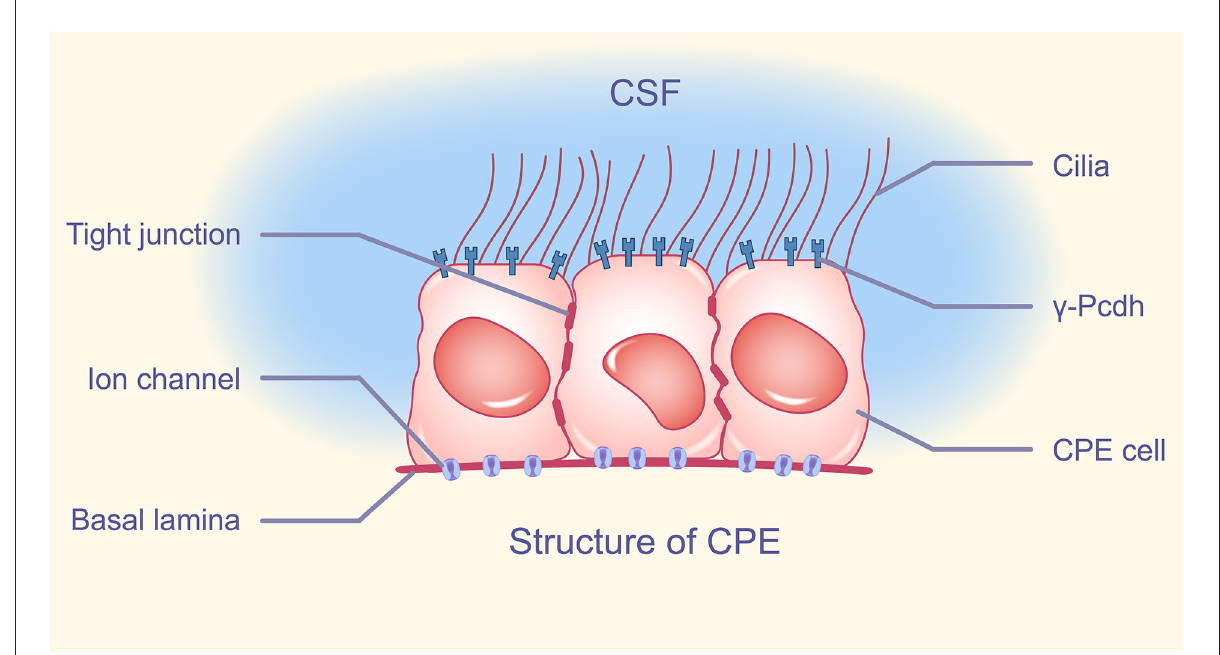
FIGURE1 Structure of CPE. The apical membrane of CPE has a variable number of cilia, intercalated between cells, tight junctions composing BCSFB, and cell adhesion molecule γ -Pcdh distributed on the apical membrane except cilia. A large number of ion channels are distributed in the basement membrane of CPE. CPE, choroid plexus epithelium; BCSFB, blood-cerebrospinal fluid barrier; γ -Pcdh, Pcdh- γ gene